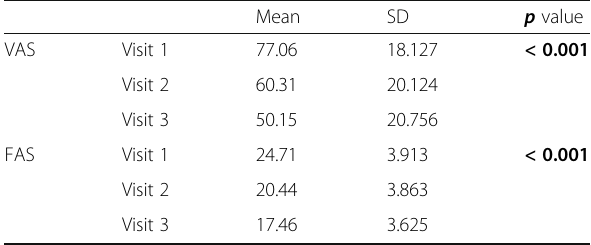
Table 5 Comparison of VAS and FAS in studied patients between follow-up